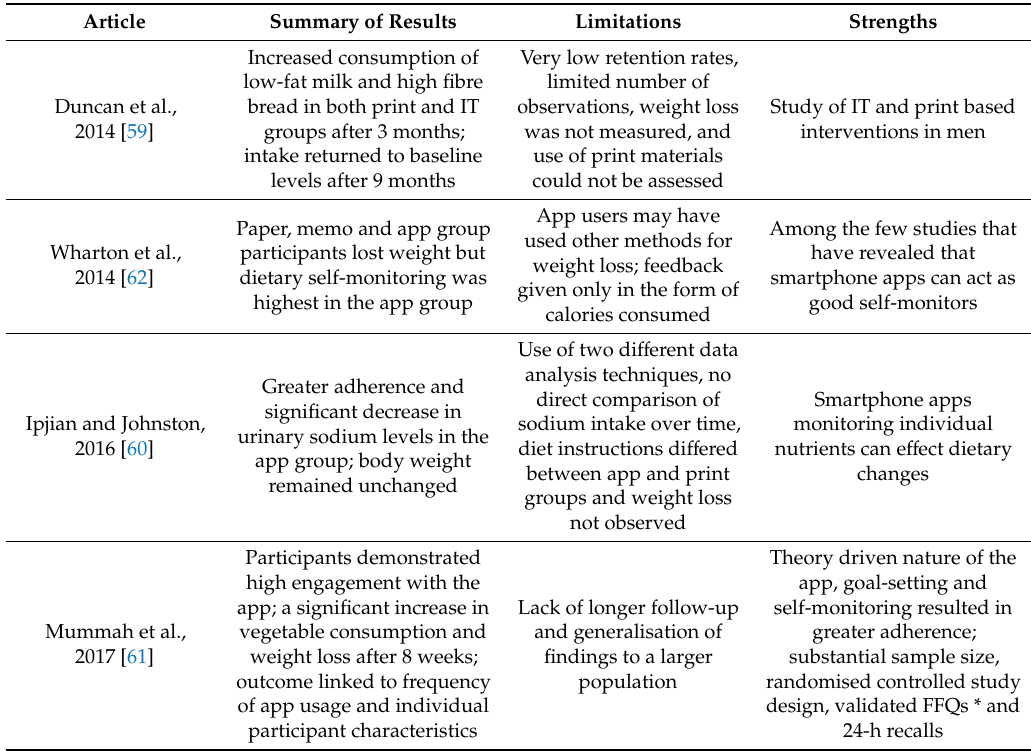
Table 5. Summary of results in studies using smartphone apps as a digital intervention for dietary behavior change.